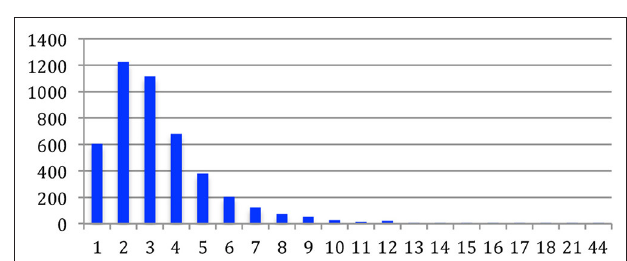
FIGURE 15 | Number of papers according to the number of co-authors.